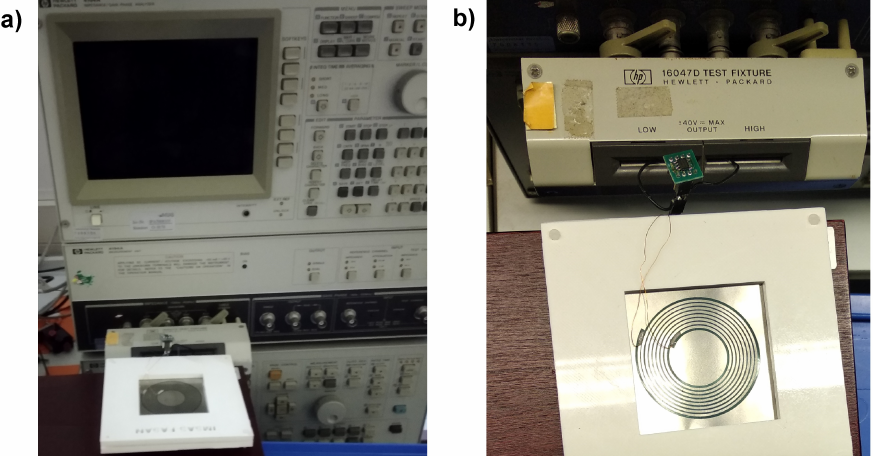
Figure A1. Measurement setup for impedance over frequency measurement. ( a ) Measurement setup with used impedance analyzer; ( b ) close up view on tested device.